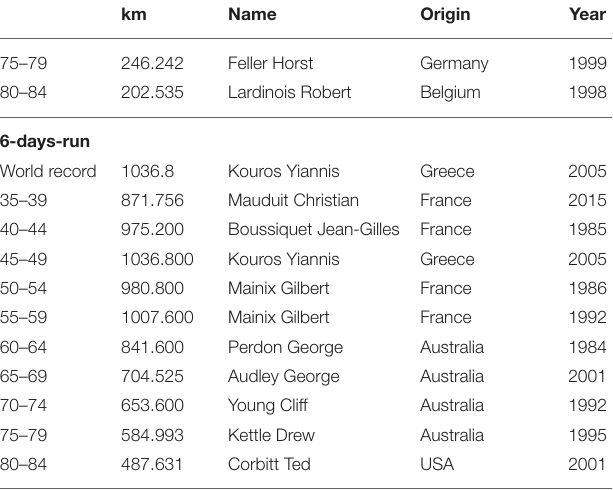
TABLE 5 | World records in men in elite and age group athletes in time-limited races, from